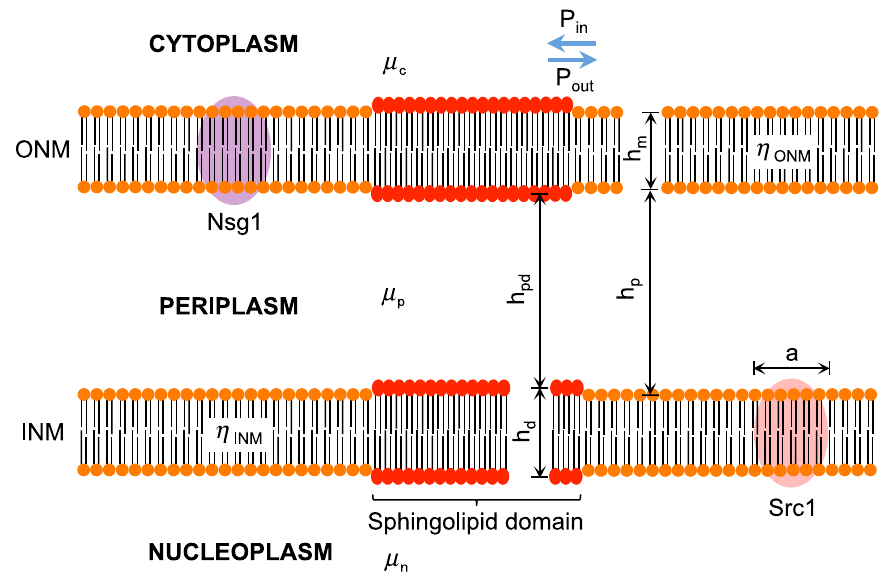
Figure 2. Sphingolipids self-organize into tightly packed, rigid and thicker domains within membranes. The increased viscosity within these domains causes membrane-bound proteins to diffuse at a lower rate. Moreover, the phase change at the boundary between the domain and the rest of the membrane may work against proteins trying to diffuse into the domain. We call this effect the protein exclusion effect. Measures indicated are: a , diameter of membrane inclusions; h x , thickness of diffusive media (membranes and periplasm); m x , bulk viscosities (measured in [Pa][s]); g x , surface viscosities (measured in [Pa][s][m]); P in and P out , probability of proteins diffusing into and out of the sphingolipid domain, respectively.